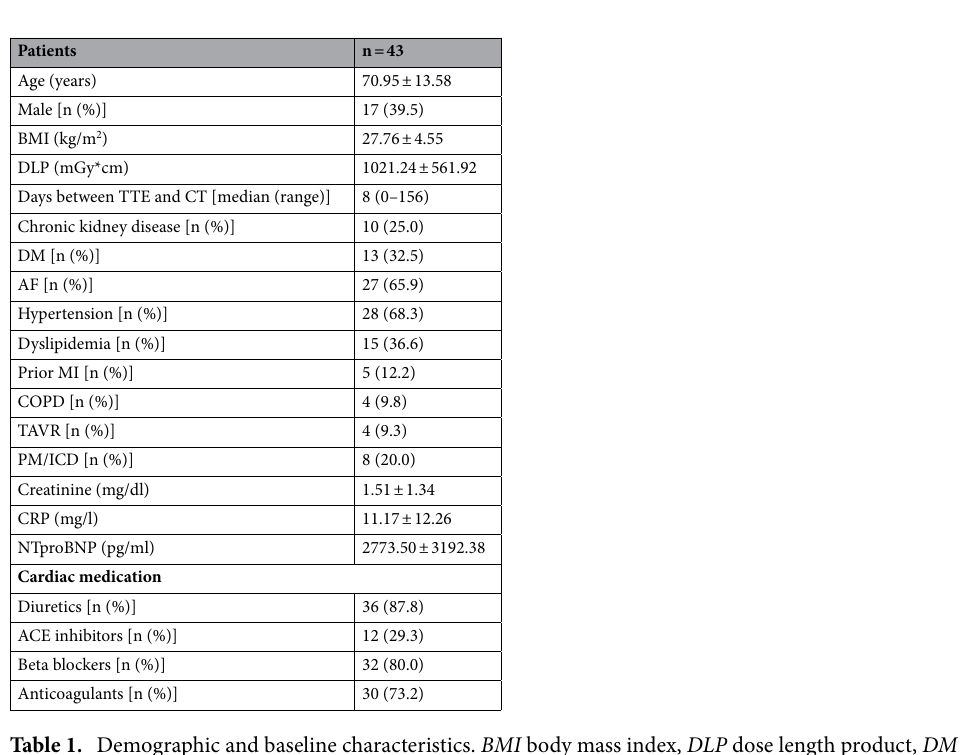
Table 1. Demographic and baseline characteristics. BMI body mass index, DLP dose length product, DM diabetes mellitus, AF atrial fibrillation, MI myocardial infarction, COPD chronic obstructive